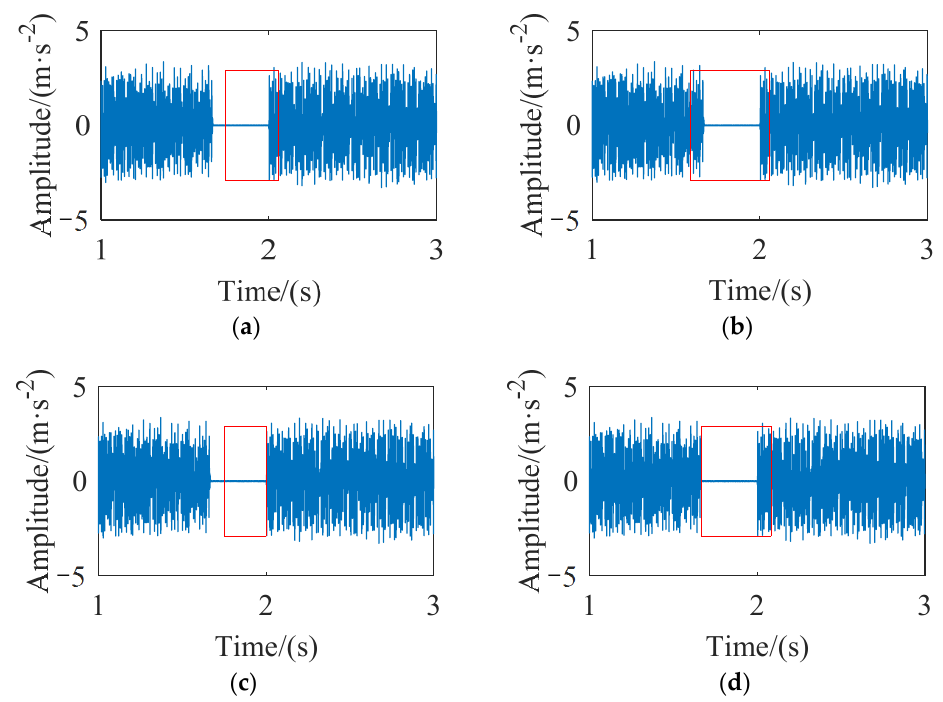
ϕ ϕ ϕ = 20; ( b ) L = 1900, = 200; ( c ) L = 3000,